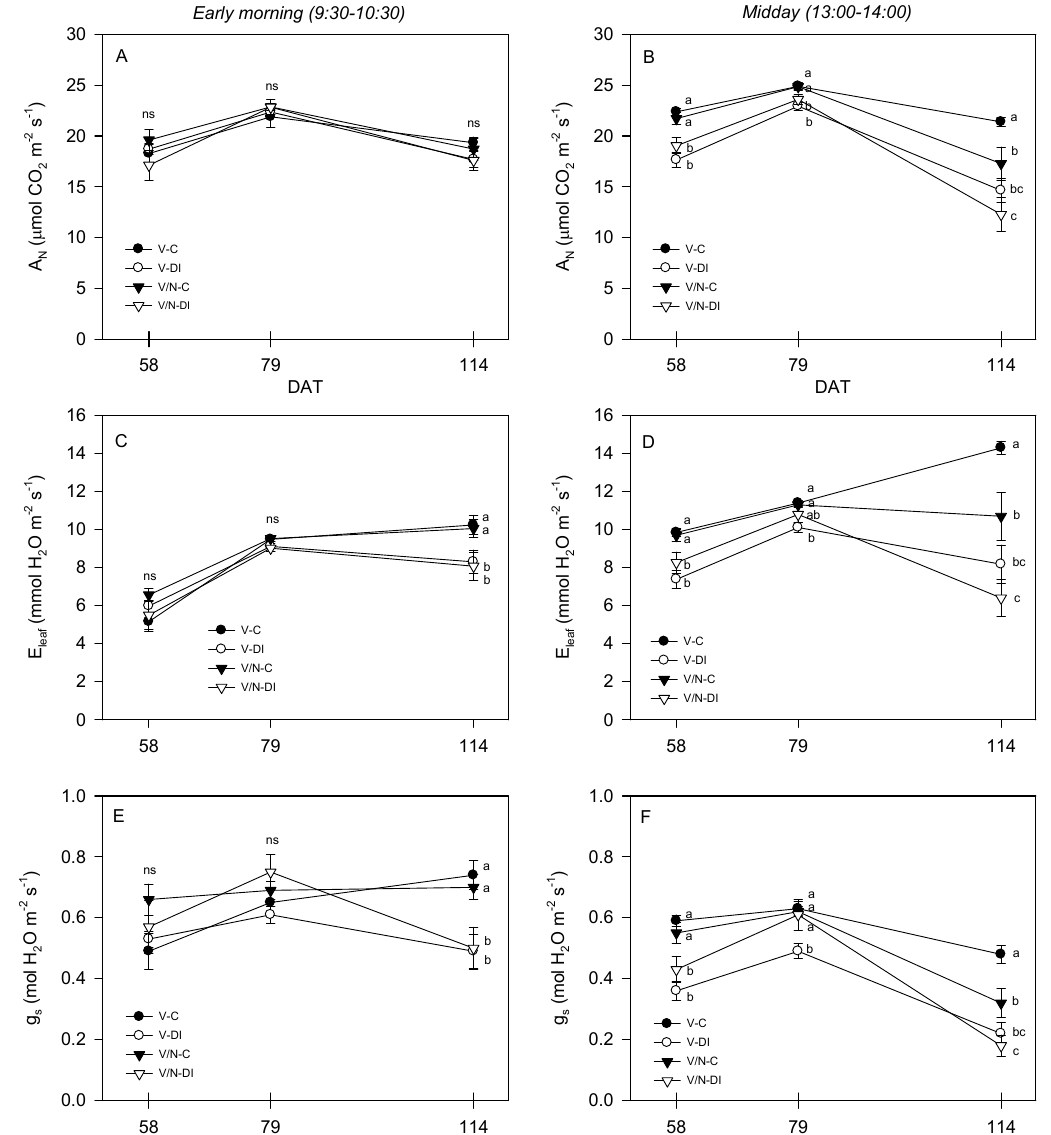
Figure 3. Net CO 2 assimilation rate (A N ) ( A , B ), leaf transpiration rate (E leaf ) ( C , D ), and stomatal conductance (g s ) ( E , F ) measured at two representative day times (early morning, midday) in the ungrafted pepper plants (cultivar ‘Maestral’, V) and the plants grafted onto NIBER ® (V / N) grown under well-irrigated (C) and deficit-irrigated (DI) conditions. Measurements were taken on 58, 79, and 114 days after transplanting (DAT). Data are the mean values for n = 9 ± SE. For each studied time, di ff erent letters indicate di ff erences at p ≤ 0.05 (LSD test). n.s. indicate no significant difference.